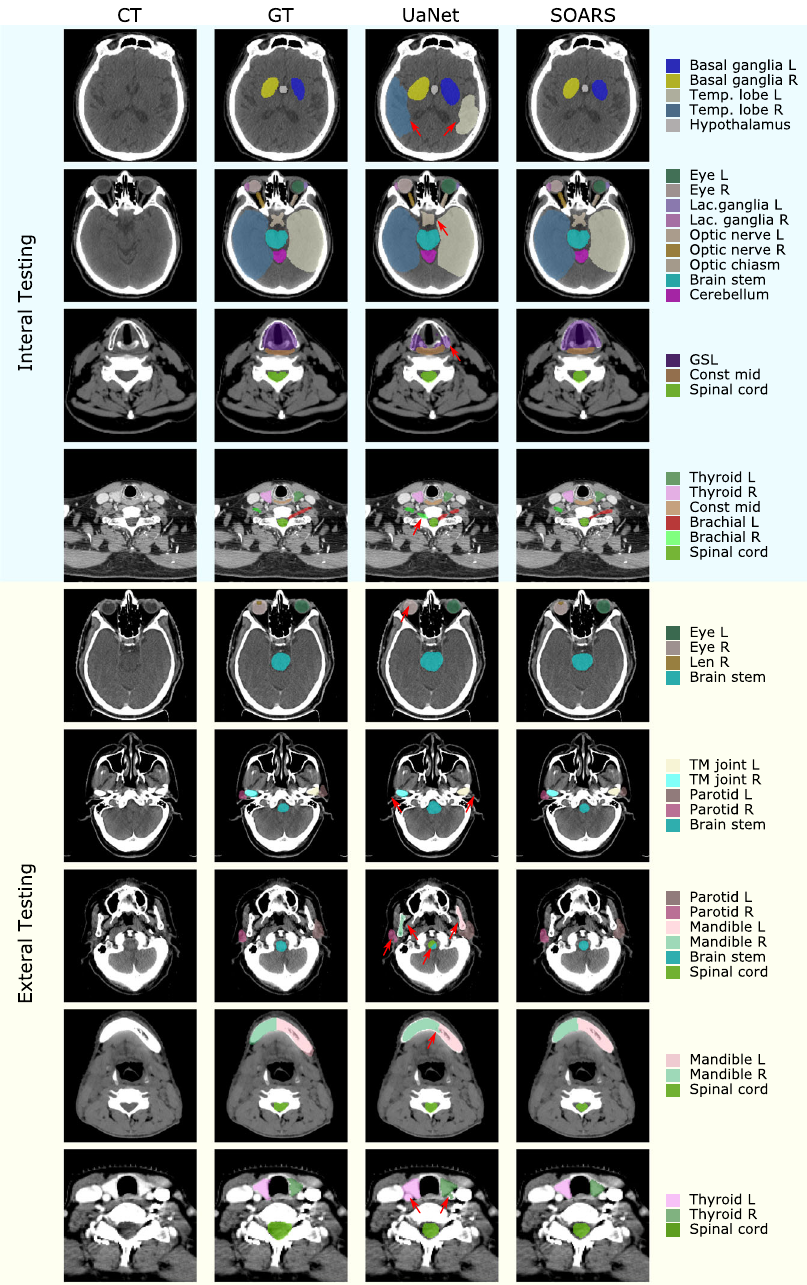
Fig. 2 | Qualitative 42 OAR segmentation using UaNet and SOARs on the internal(upper4rows)&external(lower5rows)datasets. Rows5 – 9aresample images from GPH, FAH-ZU, HHA-FU, SMU, and FAH-XJU, respectively. The 1 – 4 columns are pCT image, pCT with manual OAR delineations, pCT with UaNet